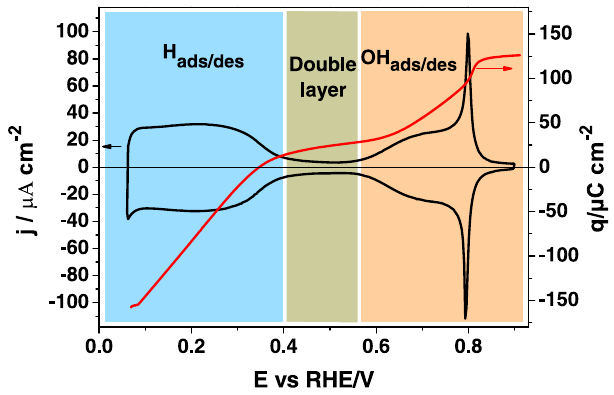
Fig. 1 State of the art for Pt(111). Cyclic voltammogram (black line, left hand axis) and charge density curve (red line, right hand axis) for Pt (111) recorded in 0.1 M HClO 4 solution at a scan rate of 50 mV s − 1 . The region in blue corresponds to the hydrogen adsorption/desorption region, the region in green to the double layer, and the region in orange to the hydroxyl adsorption/desorption